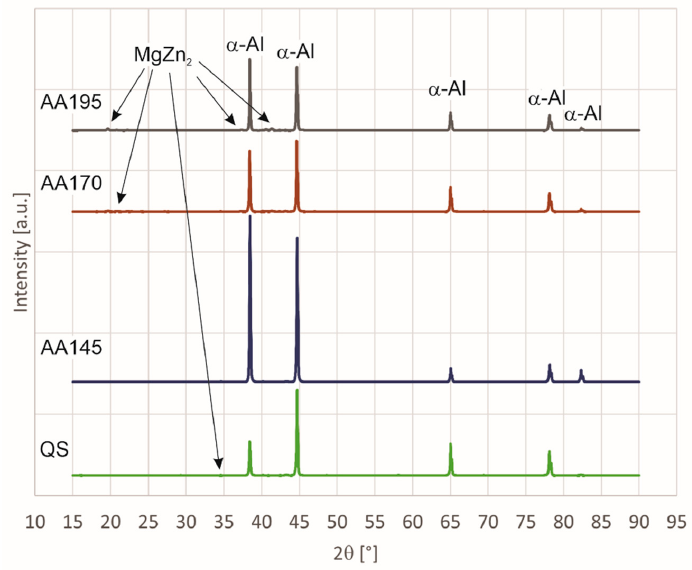
Figure 1. XRD diffraction patterns of AA7075 aluminium alloy subjected to various heat treatment conditions.